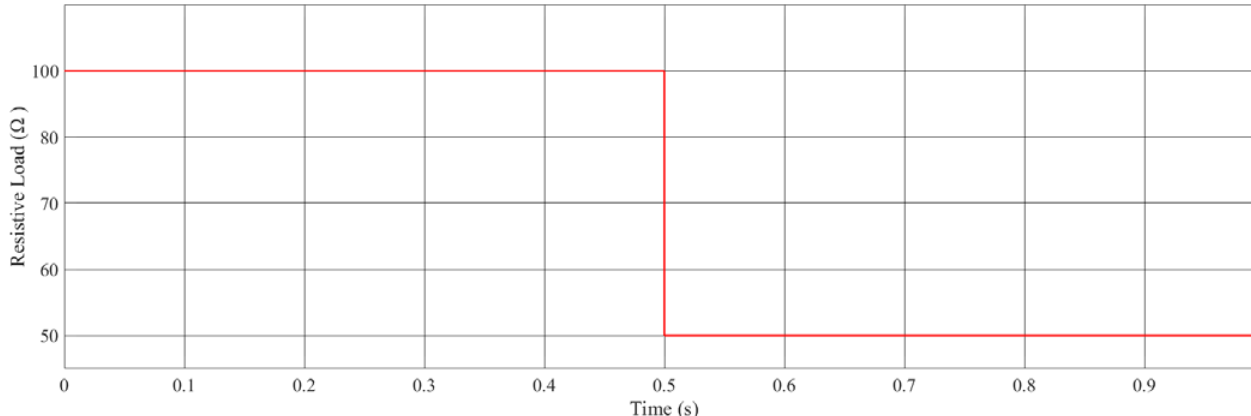
Figure 4. Load variations.